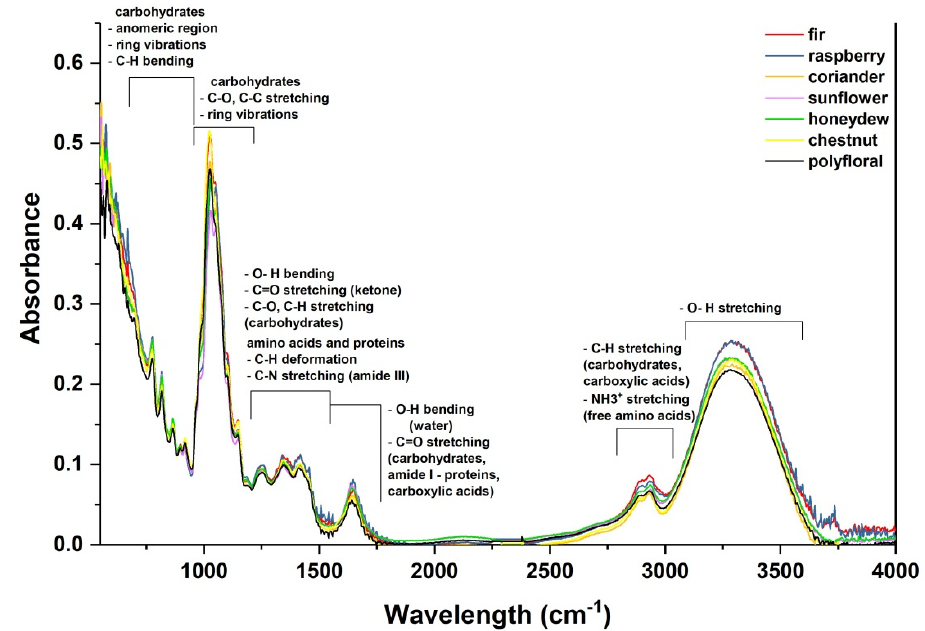
Figure 2. Experimental ATRFTIR spectra of the honey samples distribution.